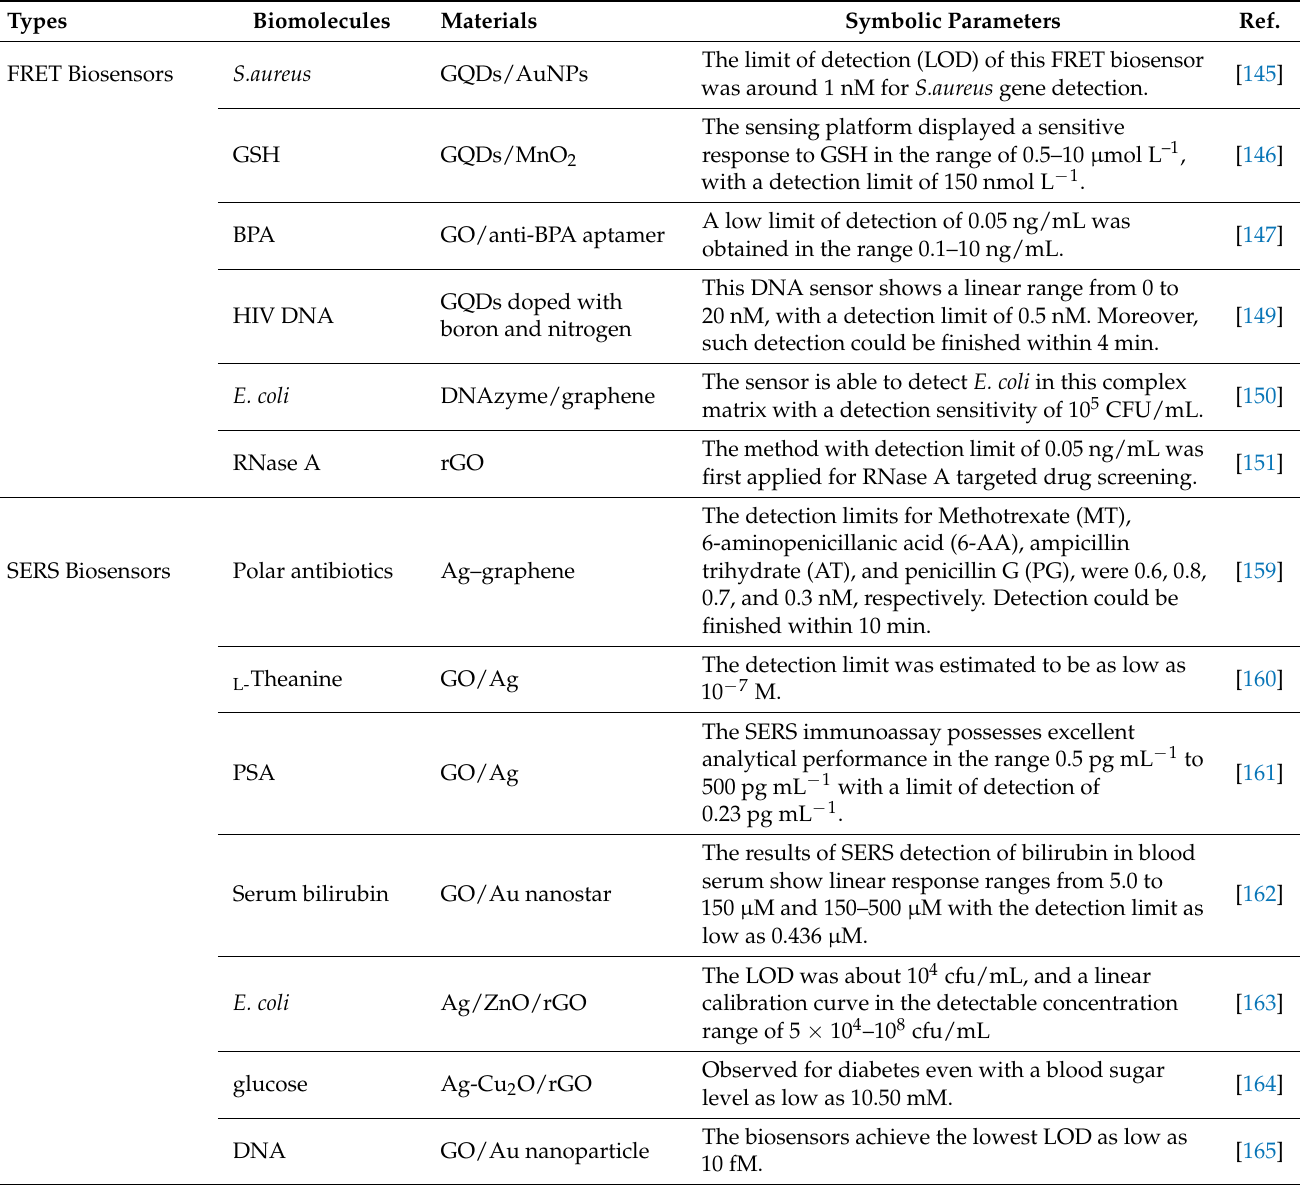
Table 2. Optical biosensors based on graphene and its